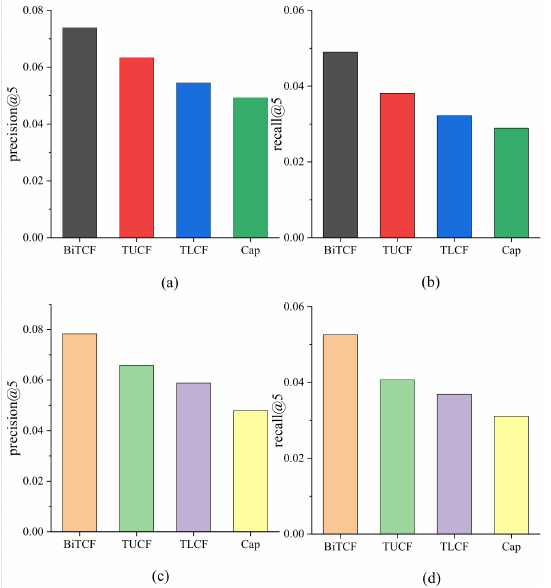
Figure 9. Comparison of the effectiveness of four modules: ( a , b ) on Gowalla; ( c , d ) on